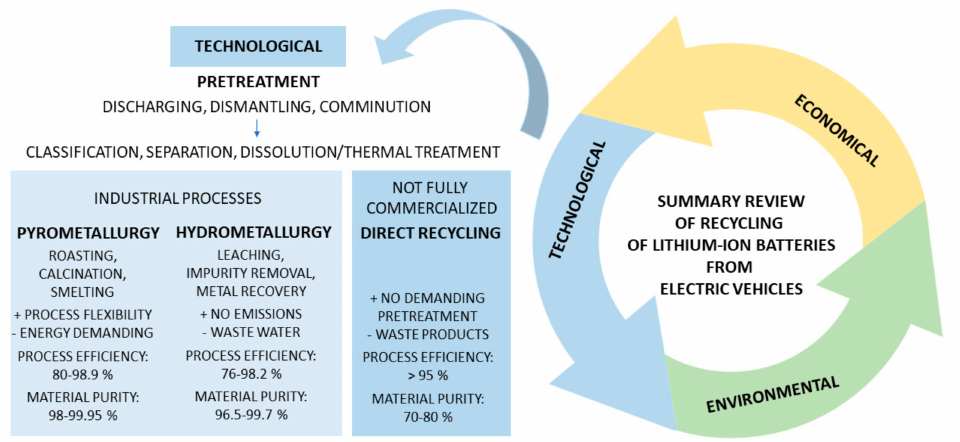
Figure 9. The summarizing figure of the first part of the literature review of recycling lithium-ion batteries from electric vehicles specialized on techniques of this